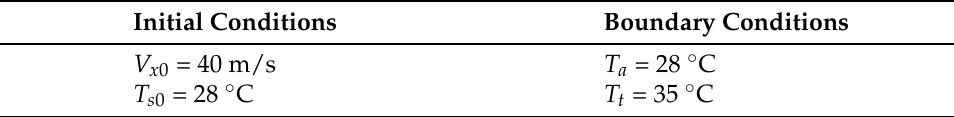
Table 2. myTyre thermal model validation test